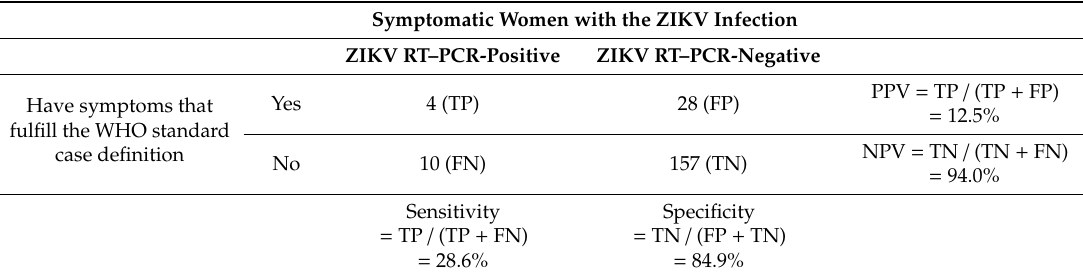
Table 4. Sensitivity, specificity, positive and negative predictive values of the WHO standard clinical case definition for ZIKV infection applied to the symptomatic pregnant women in the Jundiai Zika